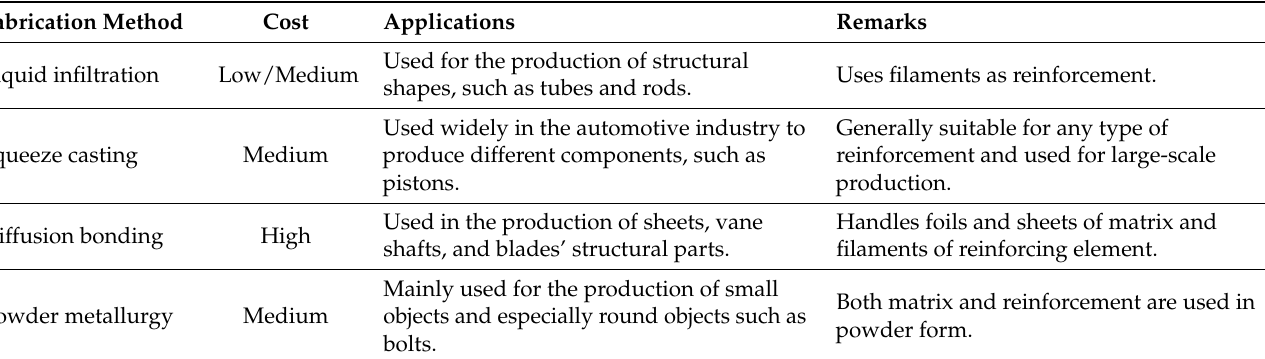
Figure 14. Gas pressure infiltration fabrication method to produce metal matrix composites (MMCs) [223] (license no. 5174930463985). Table 5. Different fabrication methods to make metal matrix composites (MMCs), adapted from [224], open